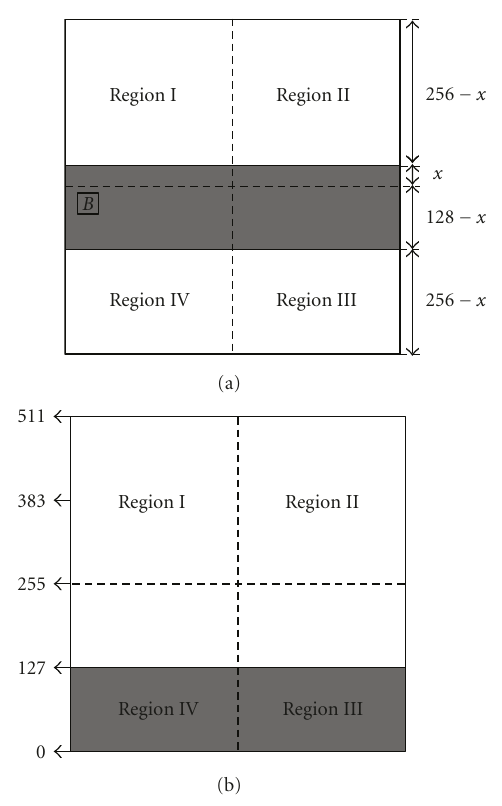
Figure 9: Analysis of 25% horizontal cropping for a 512 × 12 image. Dark area is